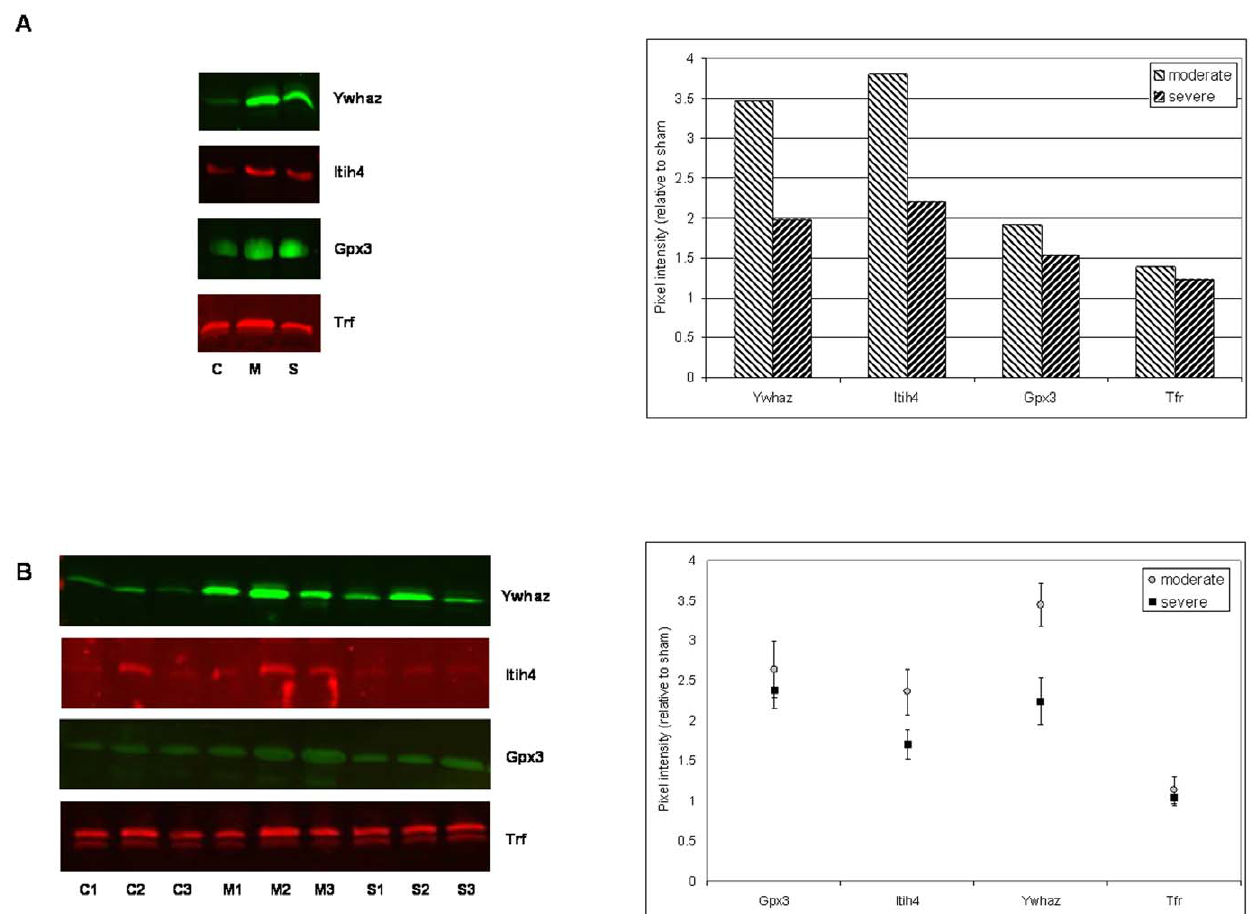
Figure 4. Western blot validation of candidate biomarkers of spinal cord injury. (a) pooled sample of CSF from 12 sham injury rats (C); pooled sample of CSF from 12 moderate injury rats (M); pooled sample of CSF from 12 severely injured rats (S). The chart on the right shows quantification of the Western blots of moderately and severely injured rats relative to sham injury, (b) three pools of CSF from four sham, moderate and severe injury rats, C1–C3, M1–M3, S1–S3, respectively. The chart on the right shows quantification of the Western blots relative to sham injury. Each data point represents mean of three samples; error bars – standard error of the mean.